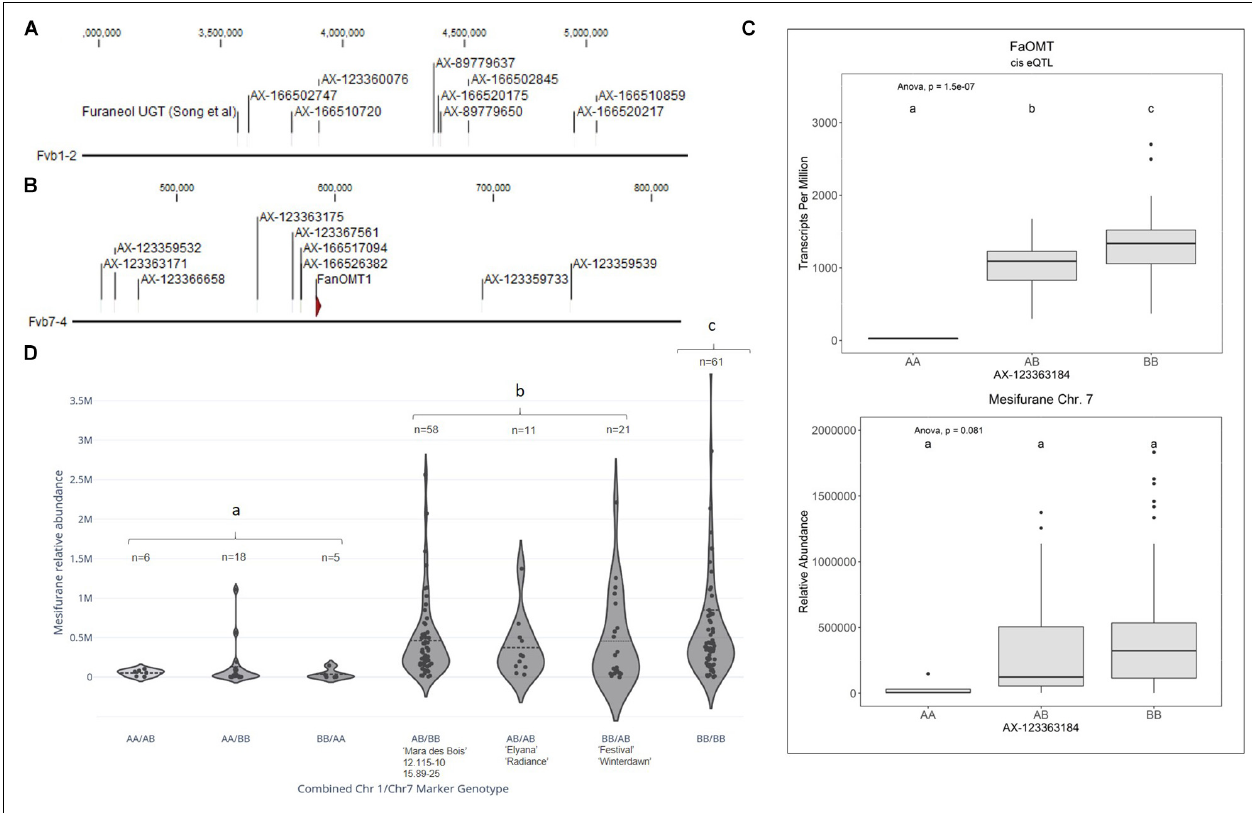
FIGURE 3 | Mesifurane QTL and candidate genes. (A) The Chr 1 mesifurane QTL markers correspond to a region containing a characterized furaneol UGT homolog. (B) The Chr 7 mesifurane QTL markers correspond to a region containing the published mesifurane FanOMT1 biosynthesis gene. (C) A cis -eQTL was detected for FanOMT1 (top), a gene known to be transcriptionally variable due to a common allele. The FanOMT1 eQTL co-segregates with mesifurane (bottom) but is confounded by additional factors. Lowercase letters indicate statistically significance mean differences at p < 0.05 (ANOVA). (D) Allelic combinations at the Chr 1 and Chr 7 markers demonstrate an epistatic effect between the two loci. At least one competent allele at each loci is required for robust production of mesifurane (AA/BB vs. AB/BB Tukey HSD p = 2.4e–7), while the double-homozygous allelic state produces statistically elevated mesifurane levels (BB/BB vs. AB/AB, AB/BB, and BB/AB ANOVA) [ F (1,149) = 4.38, p = 0.038]. The Chr 1/Chr 7 genotypes in parental lines is shown with the n of each allelic category. Dotted lines represent the population means. Lowercase letters indicate statistical significance mean differences at p < 0.05